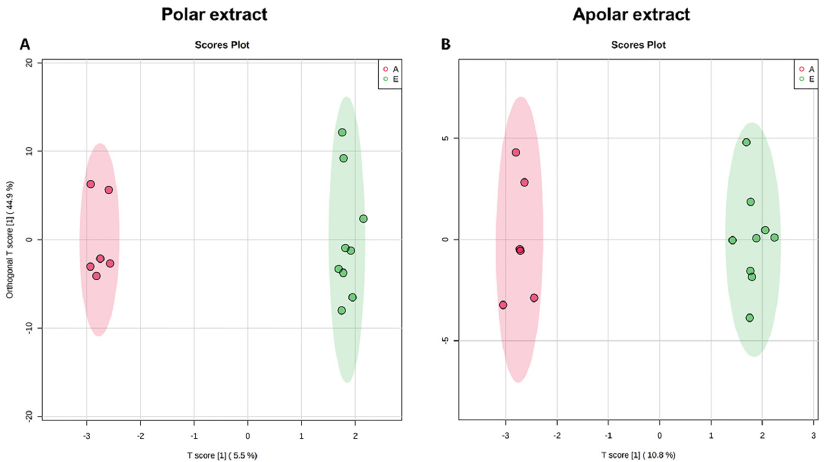
Figure 2. O-PLS-DA score scatter plot for the HRMS data acquired in ESI (+) and ( − ). Data are relative to polar ( A ) and apolar ( B ) serum extract of 9 early (green) and 6 advanced (red) ALS patients. VIP score analysis evidenced in advanced patients a higher concentration of citric acid and indoxyl sulfate and lower concentrations of some amino acids (methionine, histidine, L-isoleucyl-L-proline, and isoleucine), lysophosphatidylcholine, betaine, and creatinine. Conversely, analysis of the lipid extract showed that in advanced ALS patients, there are high concentrations of glycerophospholipids (PC, PI, and PC-Os) and low concentrations of sphingomyelins (SMs) and triacylglycerols (TGs) (Figure 3). For some of these metabolites — citric acid, L-fucose, 3-(3-4-5-trimethoxyphenyl)pro- panoic acid, oleic acid, SM 34:1;O2, SM 41:1;O2, PC 36:1 and Cer 42:0;O3 — the discrimi- nant power was confirmed by calculating the ROC curves (AUC > 0.70 p -value < 0.05) (Figures S4–S6; Tables S4 and S5).